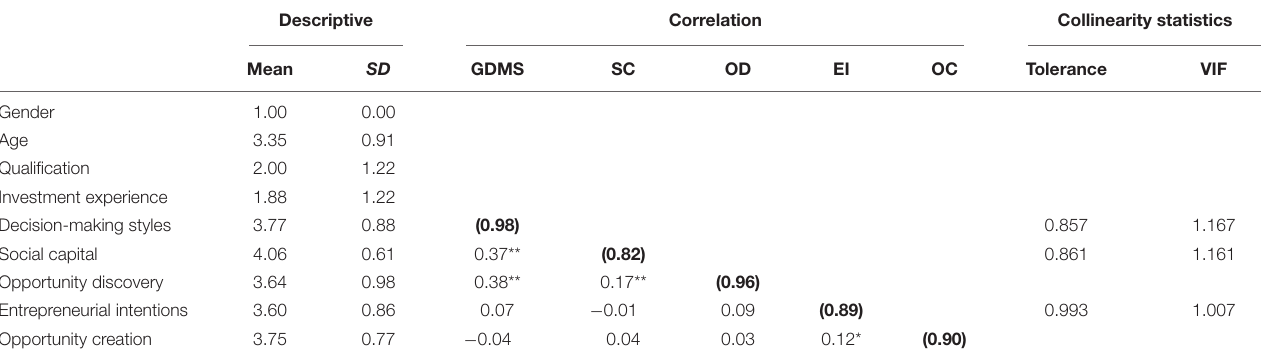
TABLE 1 | Means, SDs, correlations, and